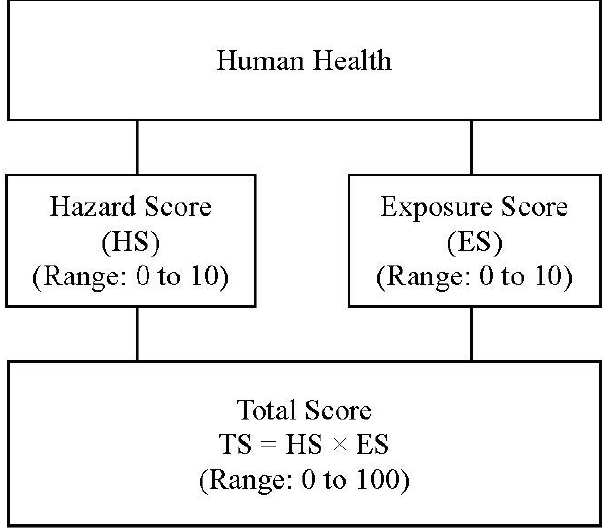
Figure 1. Algorithm for the priority ranking of workplace